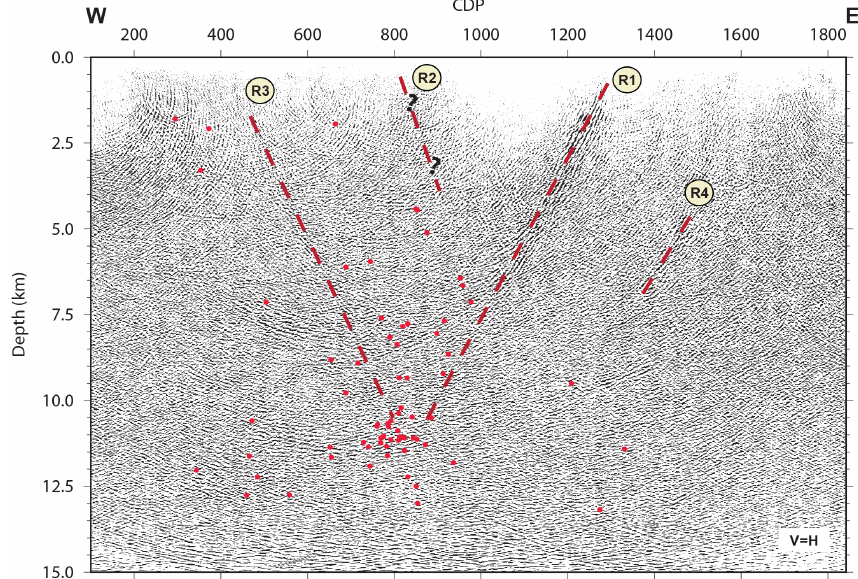
Figure 9. Cross section of the earthquakes overlaid on the interpreted migrated section. Red dashed lines depict the interpreted faults. Fault R2 was not imaged in the new seismic survey. All events within a maximum offset of 10km perpendicular to the seismic profile to the north and south are projected onto the CDP plane. A dense cluster of seismic activity is located at a depth of about 11.5km. The listric appearance of the R1 and R3 reflections at depth is most likely due to the migration process and not a feature of the faults. We have interpreted the faults to be planar based on the unmigrated